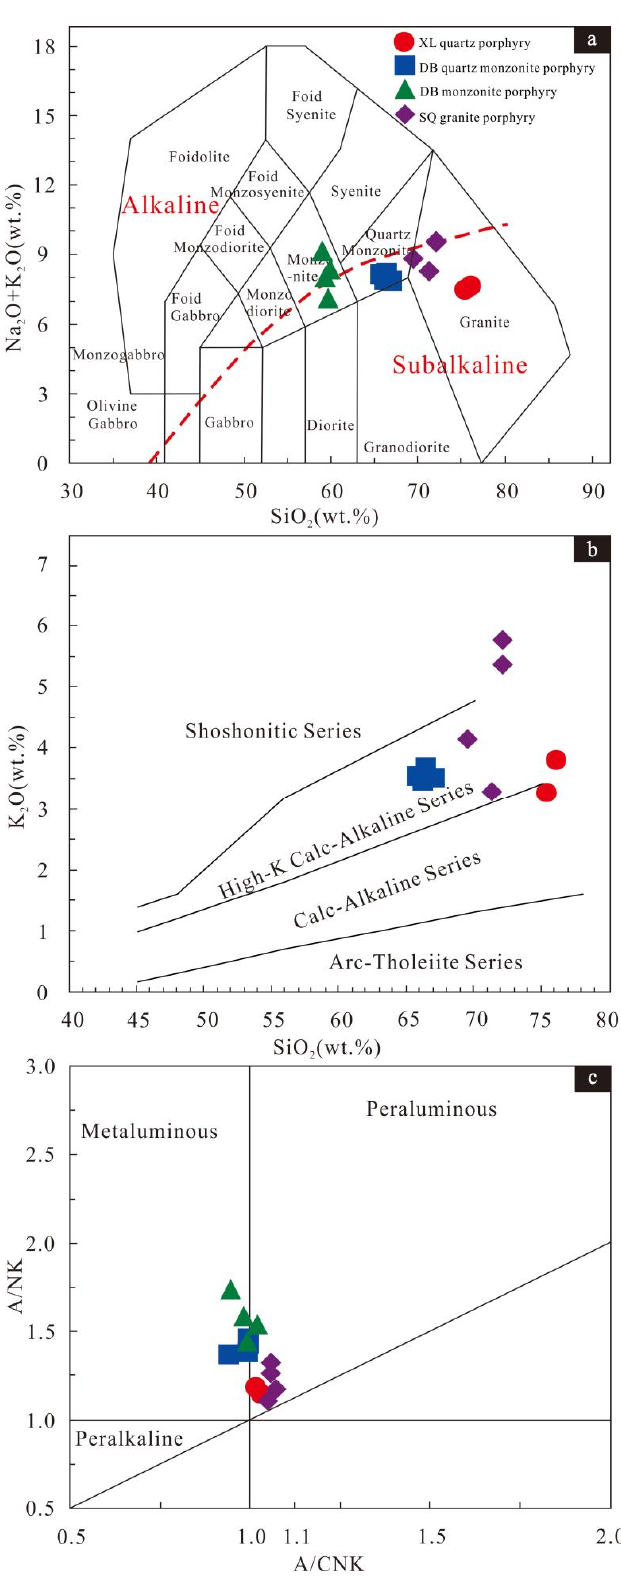
Figure 5. Classification diagrams for intrusive rocks in the study area: ( a ) TAS classification diagram (Middlemost [98] and Irvine and Baragar [99]); ( b ) SiO 2 versus K 2 O diagram (Peccerillo and Taylor [100]); ( c ) A/CNK versus A/NK diagram (Maniar and Piccoli [101]). A/CNK: Al 2 O 3 /(CaO + Na 2 O + K 2 O); A/NK: Al 2 O 3 /(Na 2 O + K 2 O) (molar ratio).